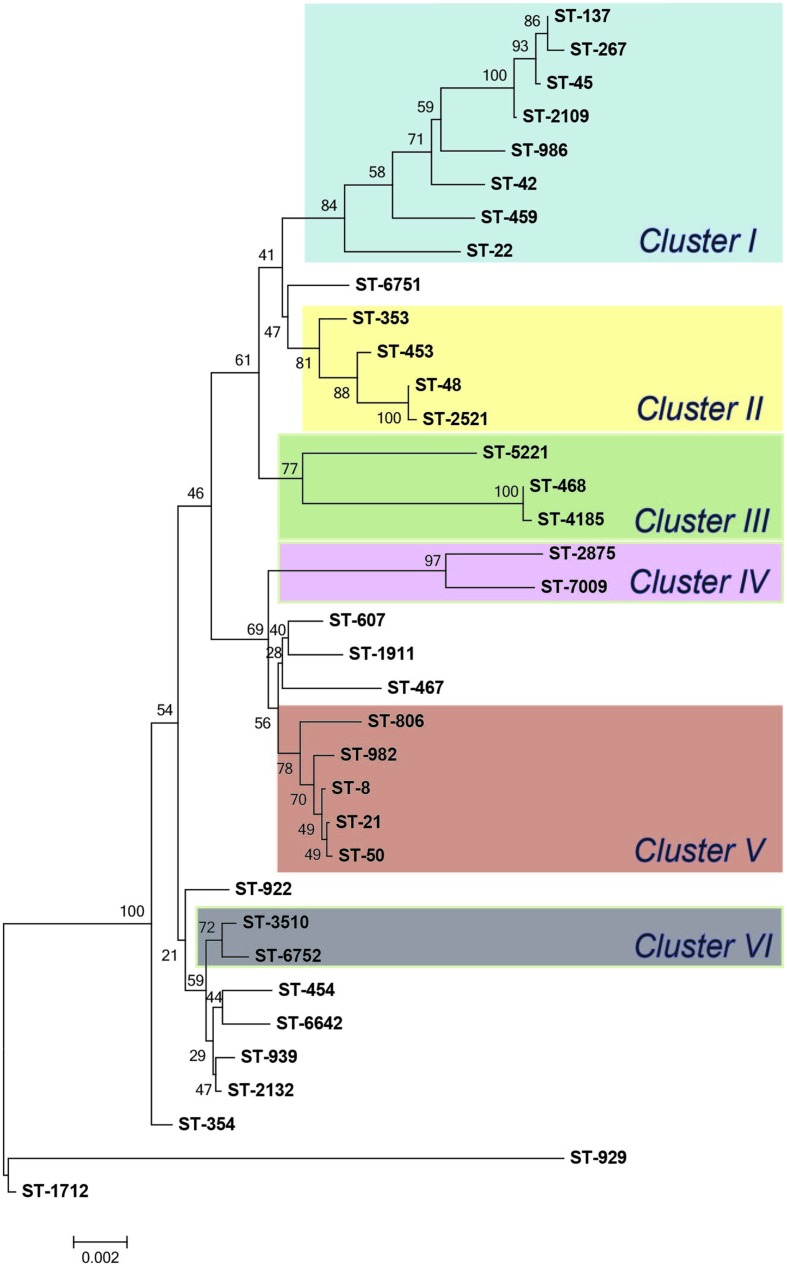
Neighbor-joining phylogeny of sequence types (STs) from Michigan (n = 52). The numbers at the end of each branch represent the STs and numbers at the nodes are bootstrap values following 1,000 replications.